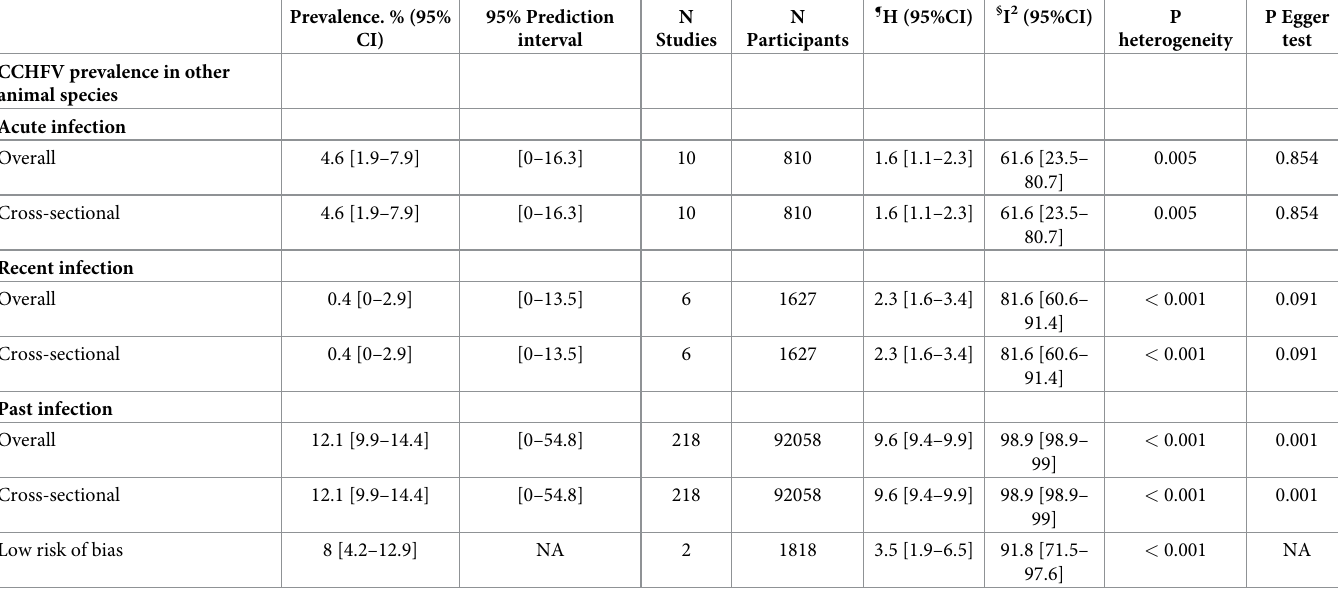
species (Figs 2 and 3). Egger’s test and funnel plot was performed to identify publication bias. The funnel plots indicate good symmetry for determining the CFR and CCHFV prevalence in other animals (S5–S14 Figs). Egger’s test indicates a significant publication bias for the